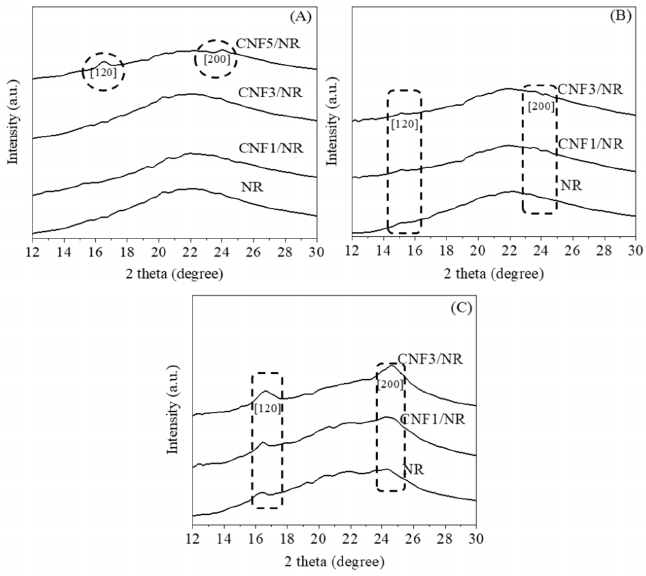
Figure 6. The 1D WAXD patterns of the NR and the CNF/NR nanocomposites measured at strains of ( A ) 200%, ( B ) 300%, and ( C ) 450%. ( A ) 200%, ( B ) 300%, and ( C ) Based on the 1D WAXD images, the crystallinity ( X c ) of the stretched NR and different CNF/NR samples could be estimated using Equation (1). The X c results are shown in Figure 7.